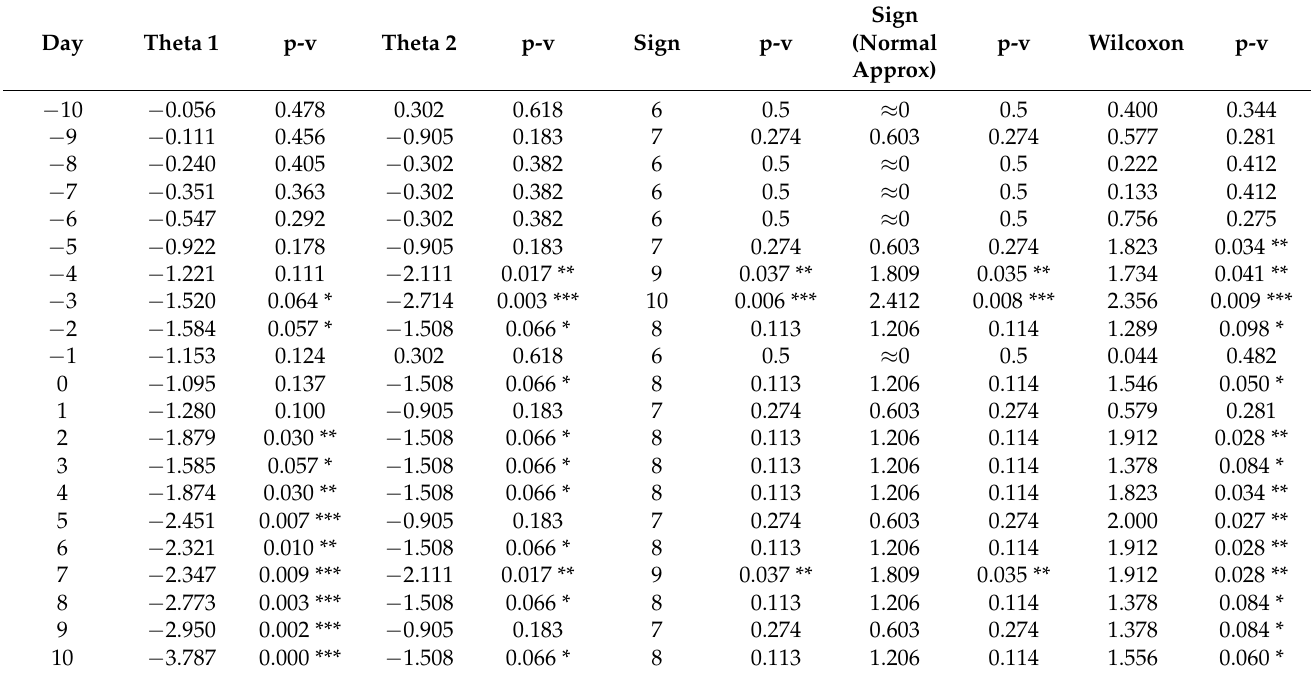
Table 5. Event study test, event 3.